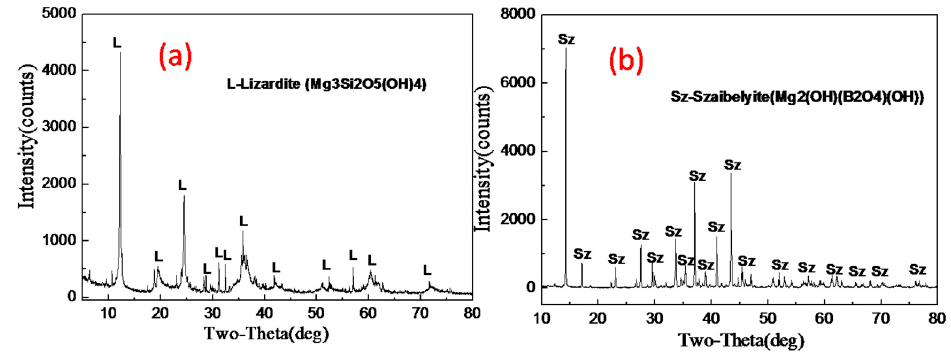
Figure 1. XRD patterns of as-prepared ( a ) lizardite and ( b ) szaibelyite samples.